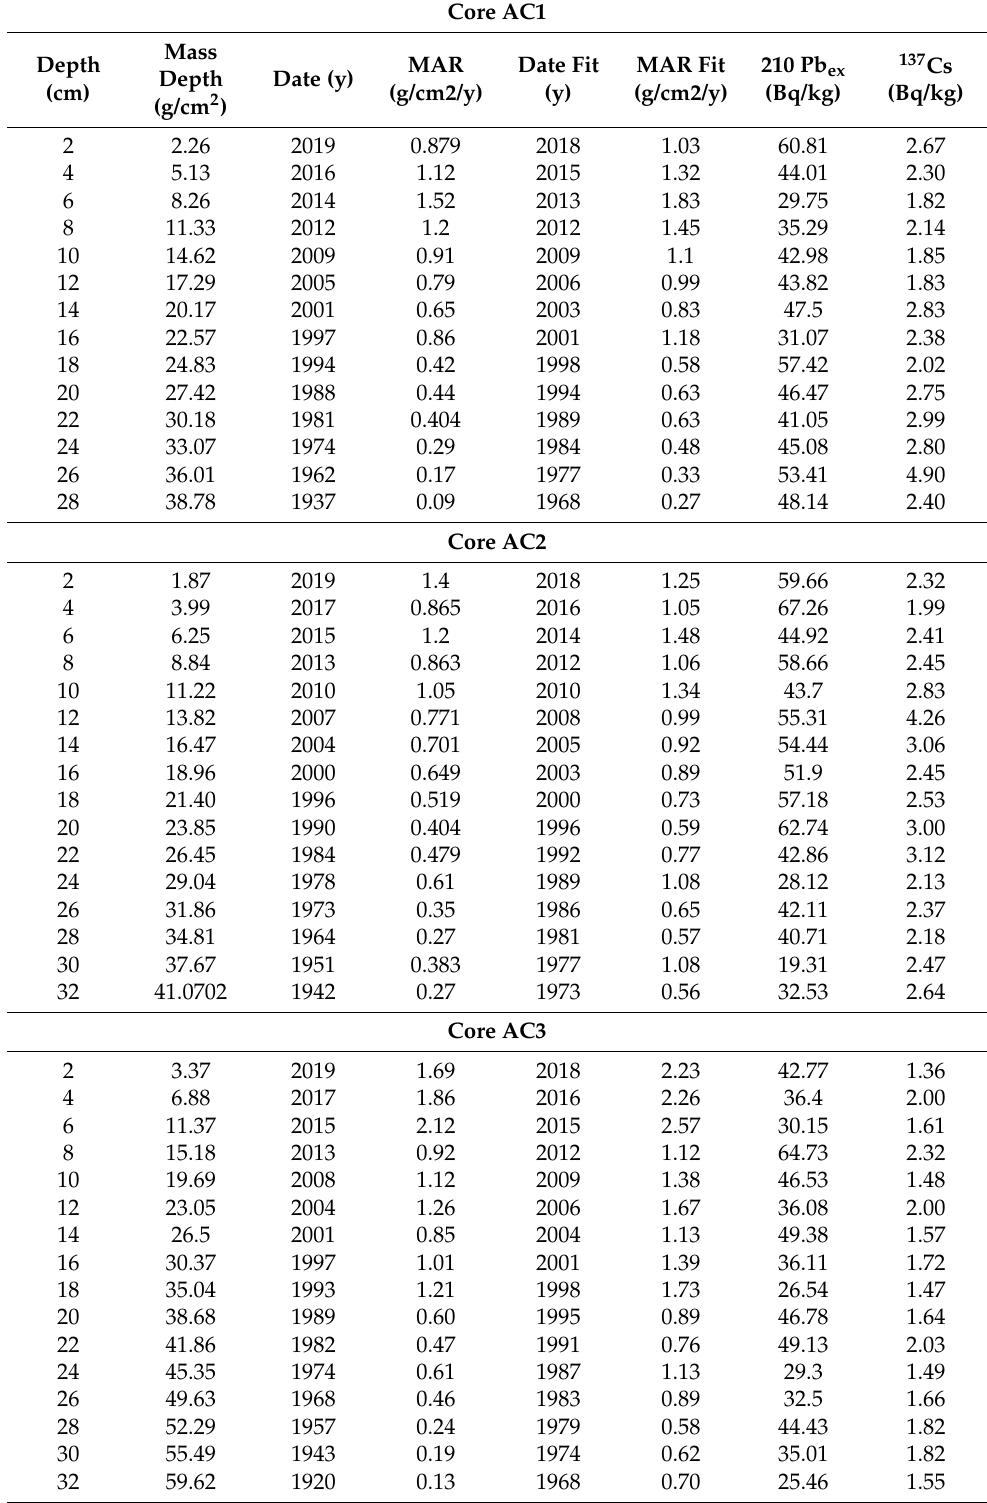
Table A1. The CRS dating results and 137 Cs laboratory results for cores AC1, AC2 and AC3 respec-